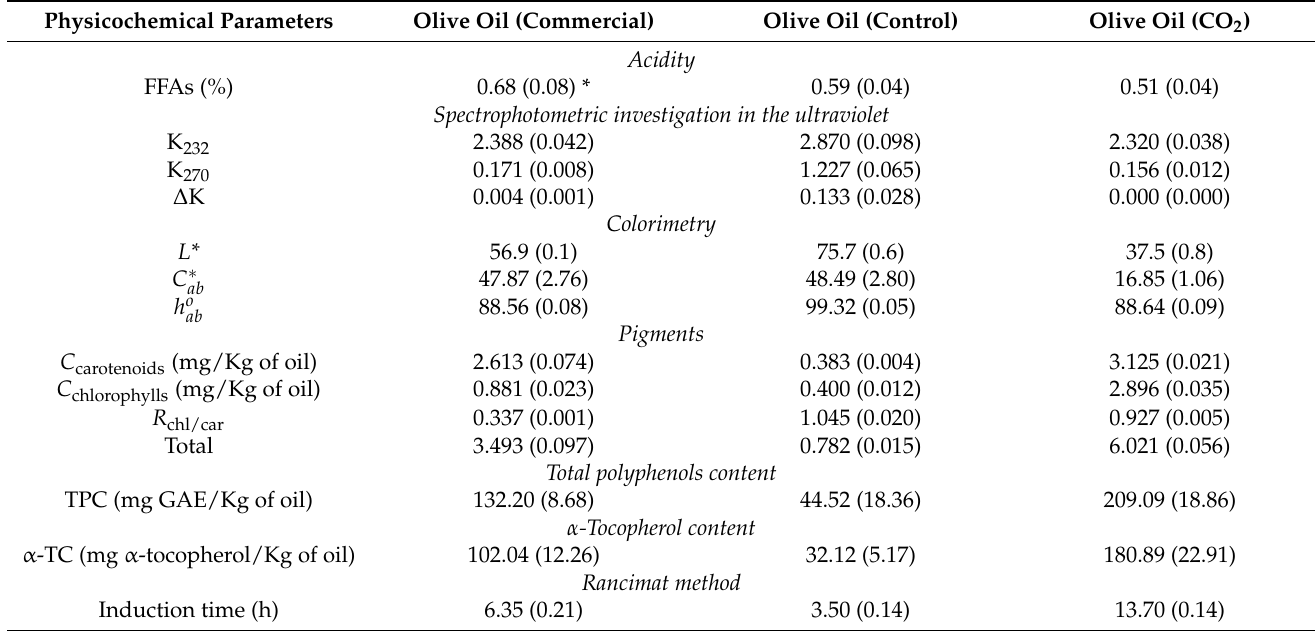
Table 3. Physicochemical composition of olive